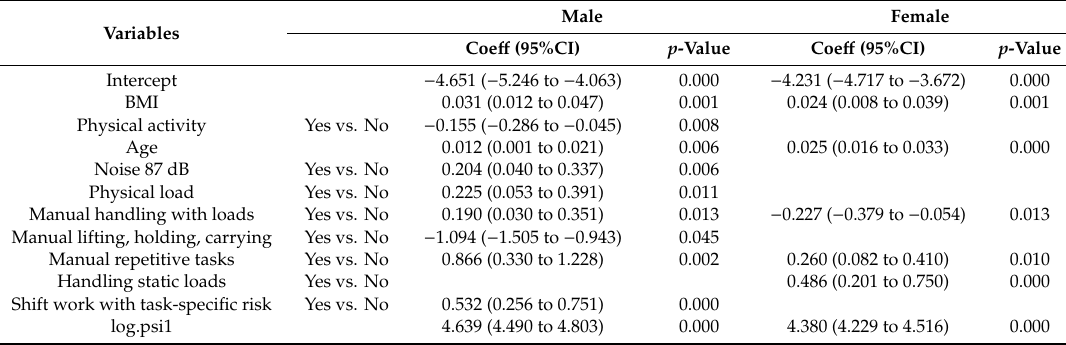
Table 3. Logistic regression model for being on medication for MSD by